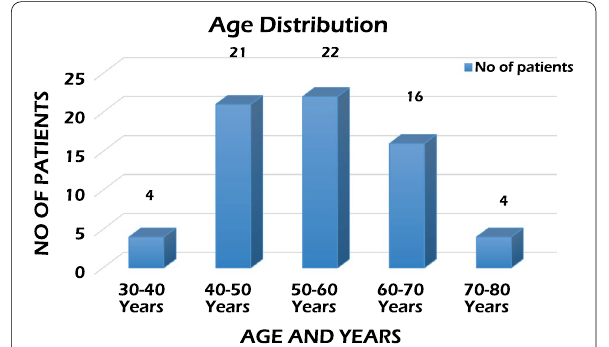
Fig. 1 Bar graph showing the age distribution of NVC